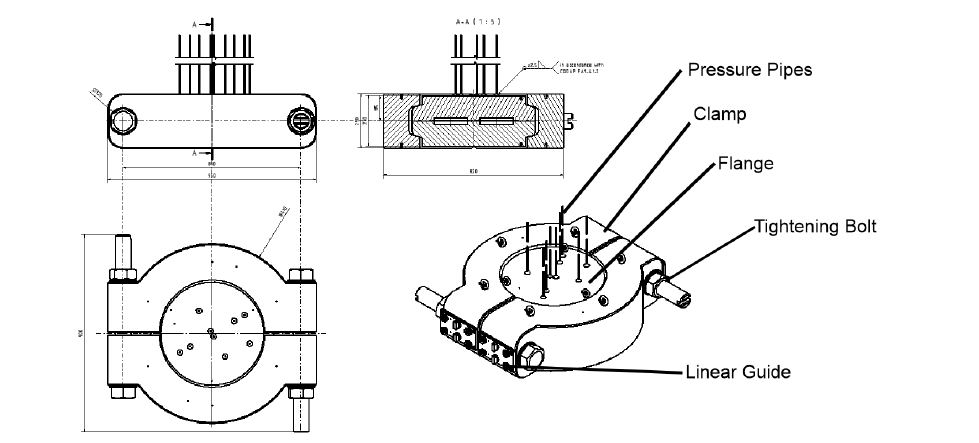
Figure 16. Technical drawing of the MPC Test